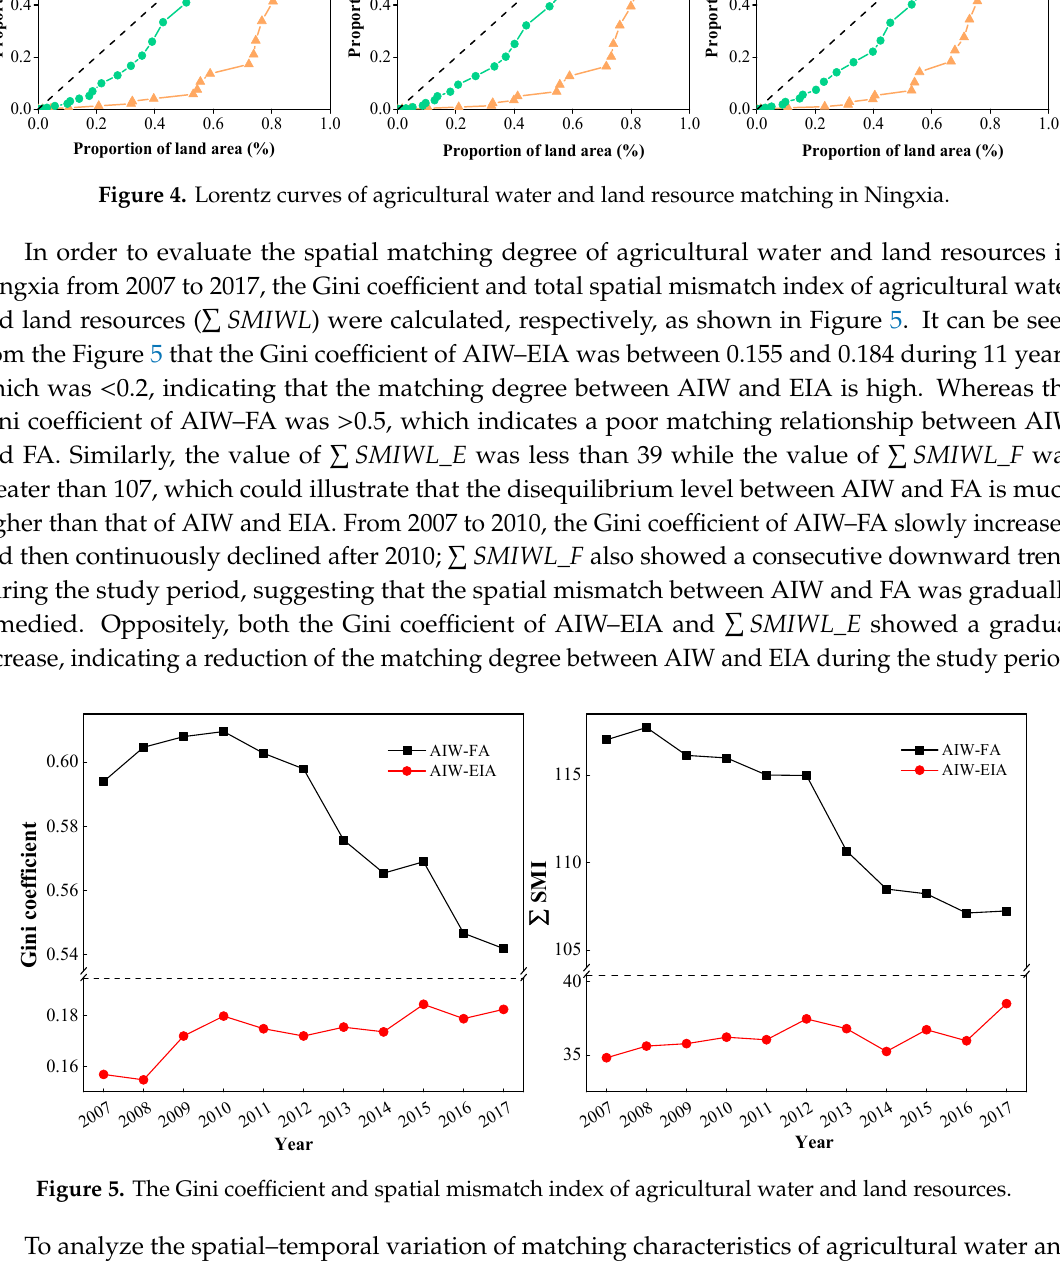
Figure 5. The Gini coefficient and spatial mismatch index of agricultural water and land resources.